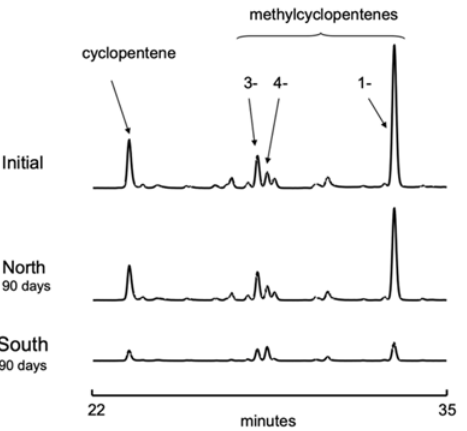
Figure 5. Purge-and-trap selected ion monitoring (m/z = 67) chromatograms of cyclopentenes in the